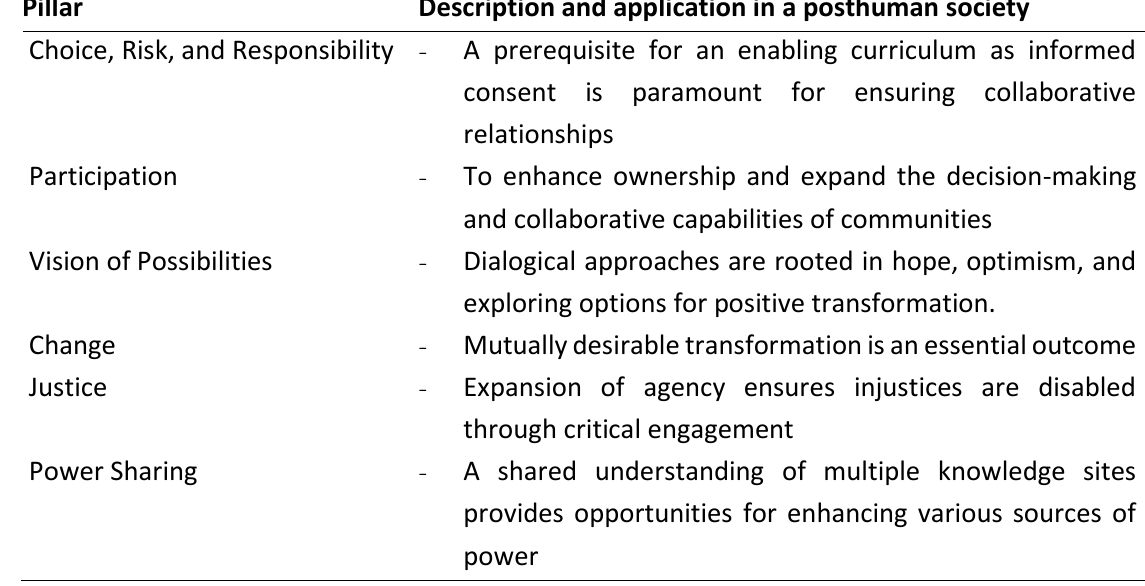
Table 1: Pillars of Enablement in Community Development Pillar Description and application in a posthuman society Choice, Risk, and Responsibility